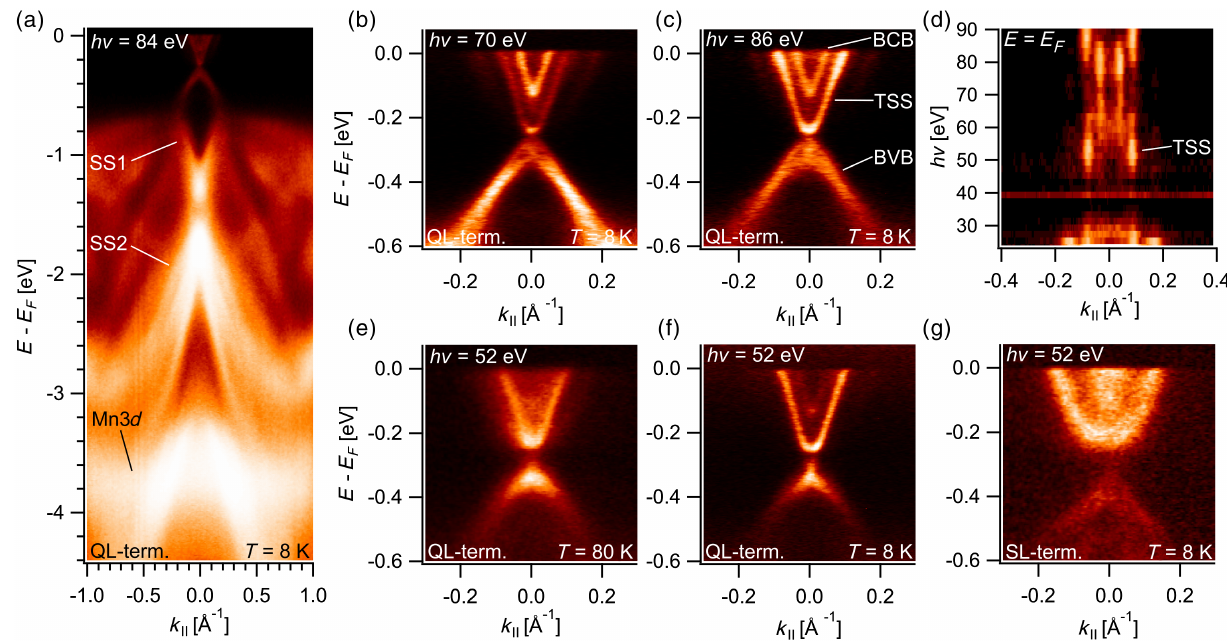
FIG. 5. Electronic structure of the Mn147(0001) surface as measured by ARPES. (a) Overview data set of the valence band structure obtained at T ¼ 8 K showing characteristic surface states SS1 and SS2 and a feature related to Mn 3 d states (cf. Figs. S9 – S12 [32]). (b),(c),(f) High-resolution data sets of the electronic structure near E obtained at different photon energies and a temperature of F T ¼ 8 K, showing a topological surface state (TSS) in the gap between conduction and valence-band derived states (BCB and BVB). (d) Photon-energy dependence of the ARPES intensity at E ( T ¼ 8 K). (e) Same as in (f), but for T ¼ 80 K. (g) Same as in (f), but for a F septuple layer (SL) termination. All other data sets in Fig. 4 are assigned to a quintuple layer (QL) termination. The ARPES data sets in ¯ Γ ¯ M Fig. 5 are measured along the - high-symmetry